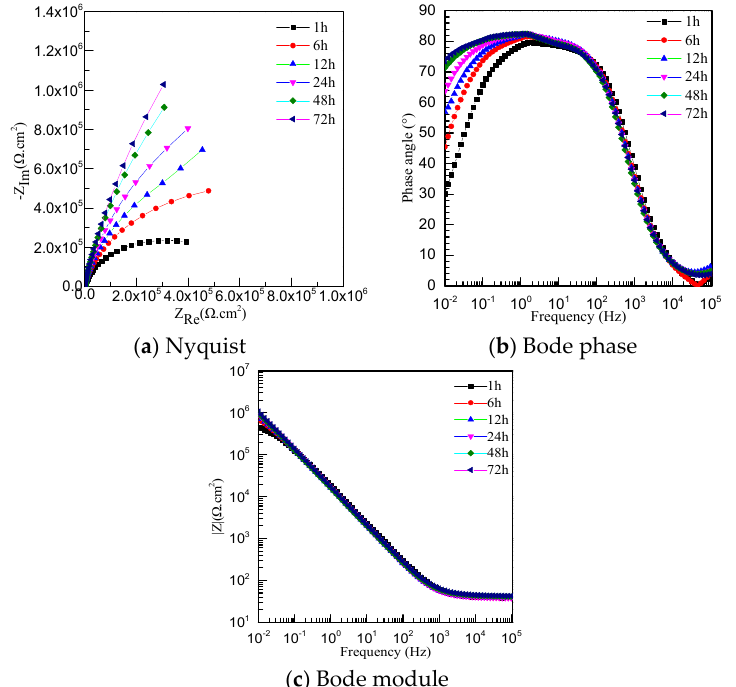
Figure 7. EIS spectra of J P-T measured at OCP after different immersion times in 1 M NaCl solution.